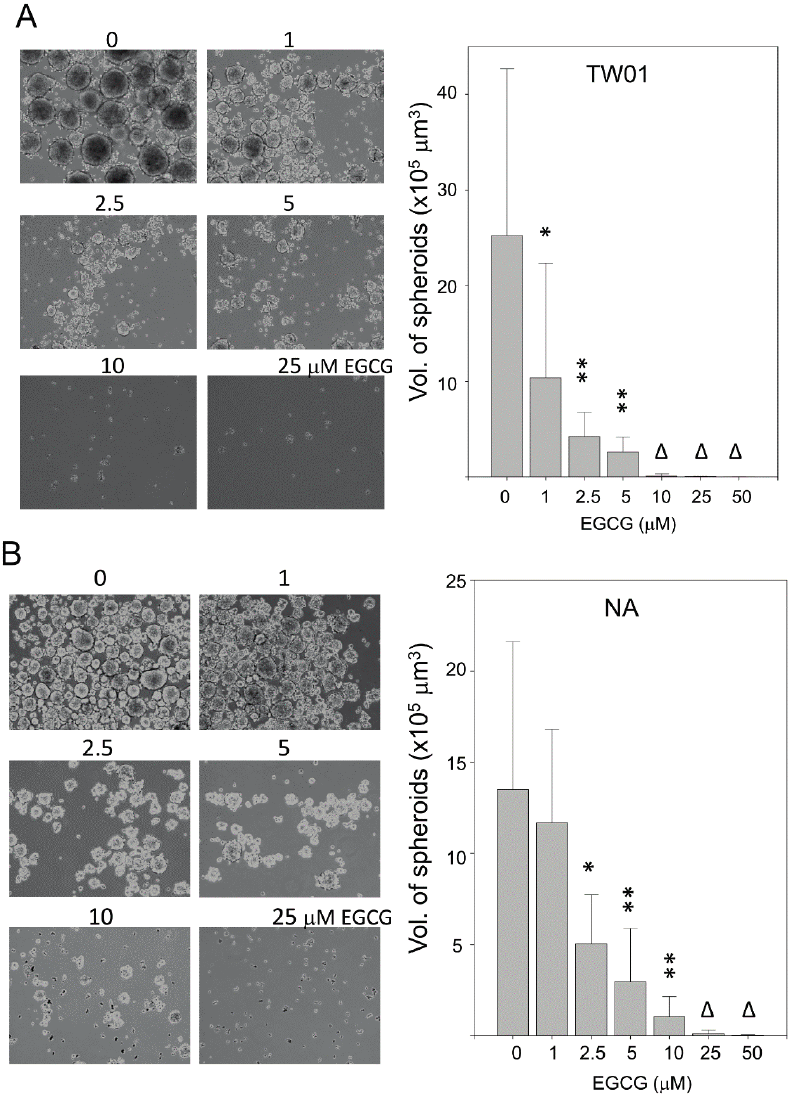
Figure 5. EGCG reduces the spheroid formation of NPC cells in culture. Cells were cultured in single-cell suspension for 7 days with EGCG treatment. The volumes of the spheroids were measured and are presented as a bar chart. Data indicate the average volume of spheroids (mean ± SD). At least 100 spheroids were measured for each experiment. *: p < 0.05; **: p < 0.01, compared to the mock-treated cells. Δ : No solid spheroid formation was observed. ( A ) TW01 cells; and ( B ) NA